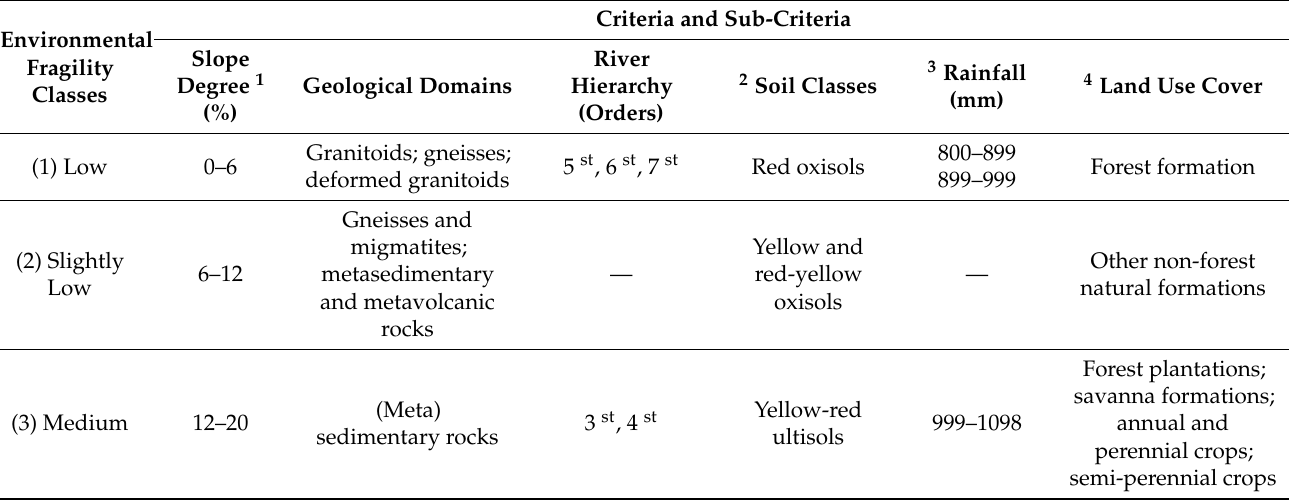
Table 4. Classes and weights for the environmental fragility in the Jequitinhonha River Hydrographic Basin according to different criteria and